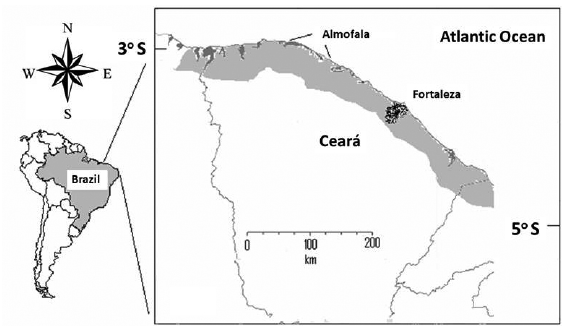
Figure 1. Map showing the location of Almofala coast in Ceará State, Brazil, where samples were obtained.